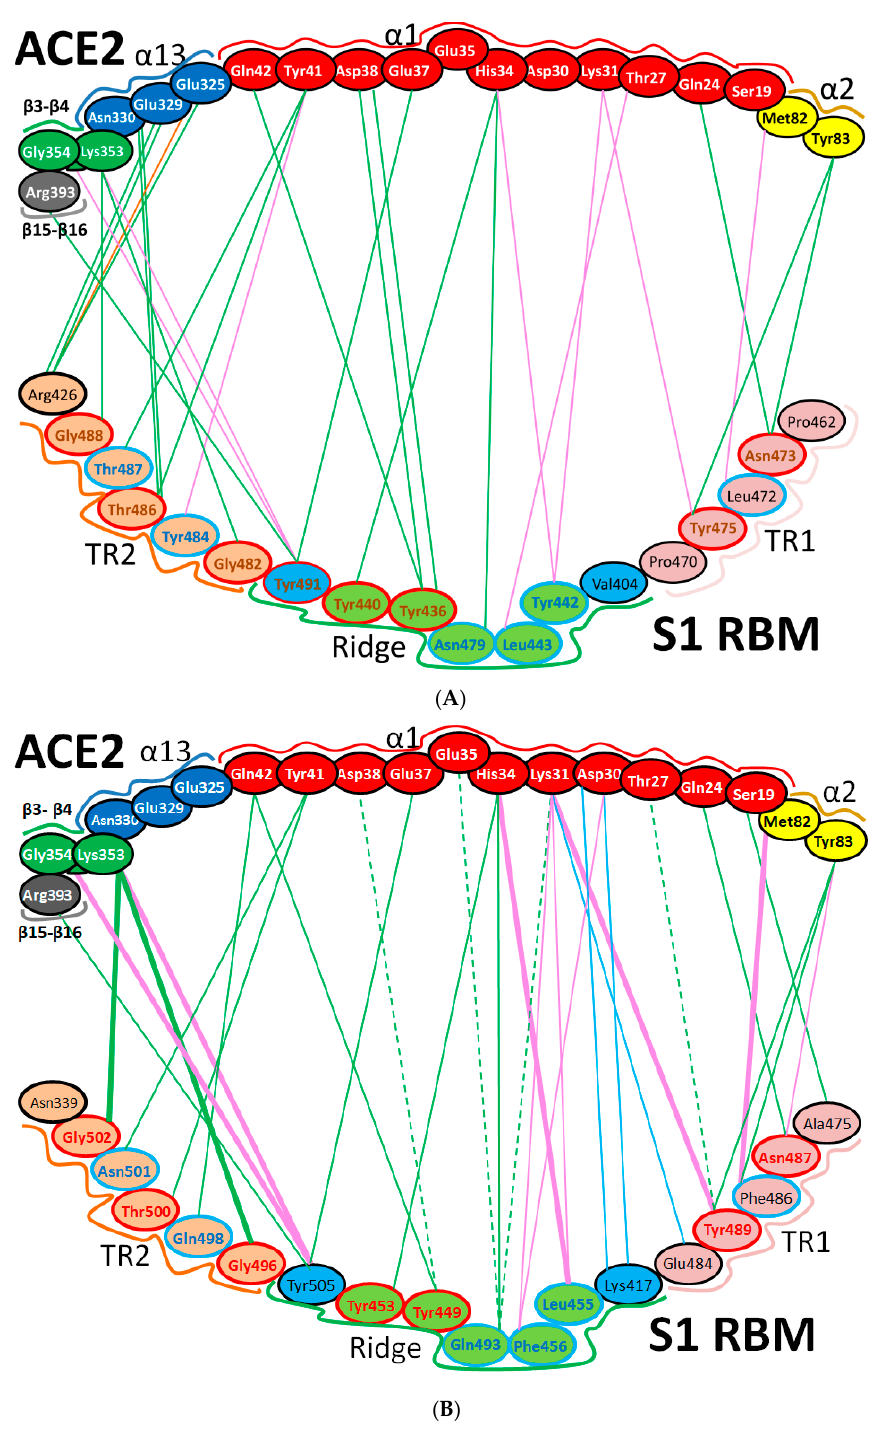
Figure 12. Cartoon representation of the interactions between ACE2 and the RBM of SARS-CoV and SARS-CoV-2. ( A ) SARS-CoV (based on PDB: 2AJF) and ( B ) SARS-CoV-2 (based on PDBs: 6LZG and 6M17). Hydrogen bonding interactions, hydrophobic interactions, and electrostatic interactions are shown by green, pink and orange lines, respectively. In the RBM regions, residues with red outlines are identical, while residues with cyan outlines are different amino acids with partially conserved contacts. The black outlines show different amino acids with different contacts. For interactions that are shown for SARS-CoV-2, the solid lines are attributed to interactions monitored in PDB:2AJF, while the dashed lines are attributed to those in PDB:6M17. Thick lines represent the common interactions between the two SARS-CoV-2 PDBs. “ α ” and “ β ” refer to alpha helix and beta sheet, respectively.